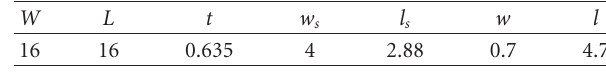
Figure 2: Geometry of the CDRA under exam, top view (right) and 3D view (left). Table 1: CDRA setup dimensions [millimeters].